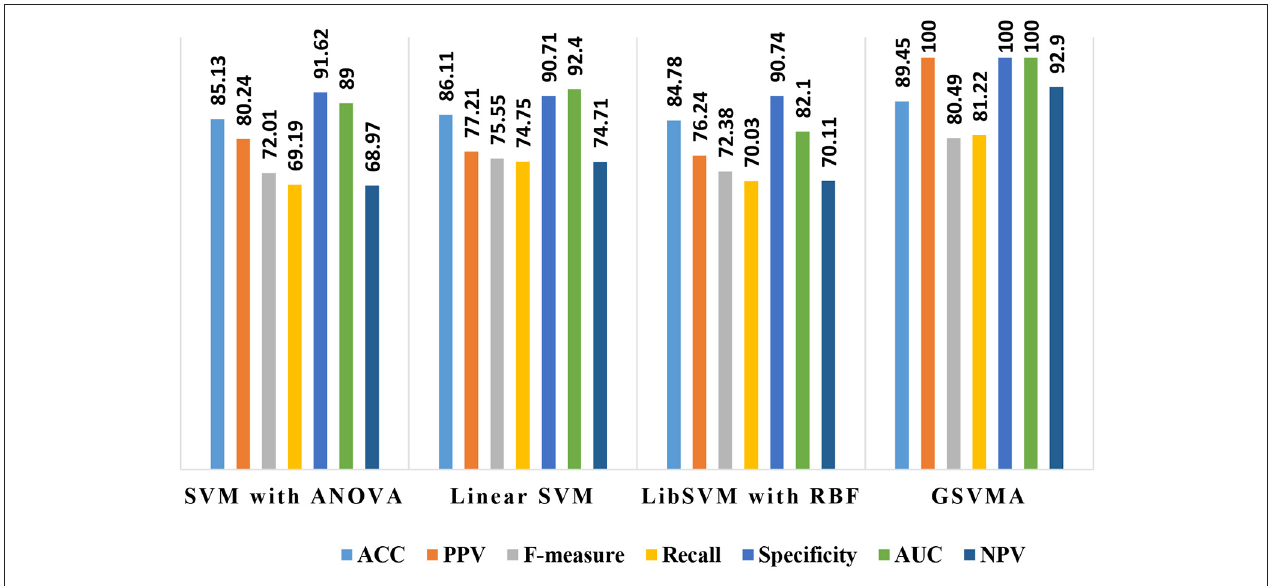
FIGURE 13 | A comparison between the performance of methods based on the seven criteria.